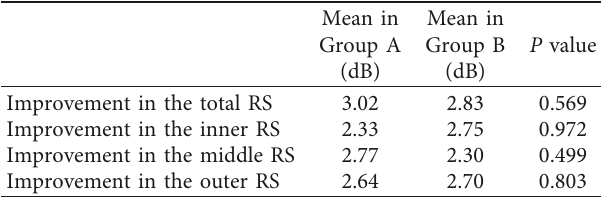
Table 3: The values of improvement in the average total retinal sensitivity as well as sensitivity in the inner, middle, and outer rings in Group A and Group